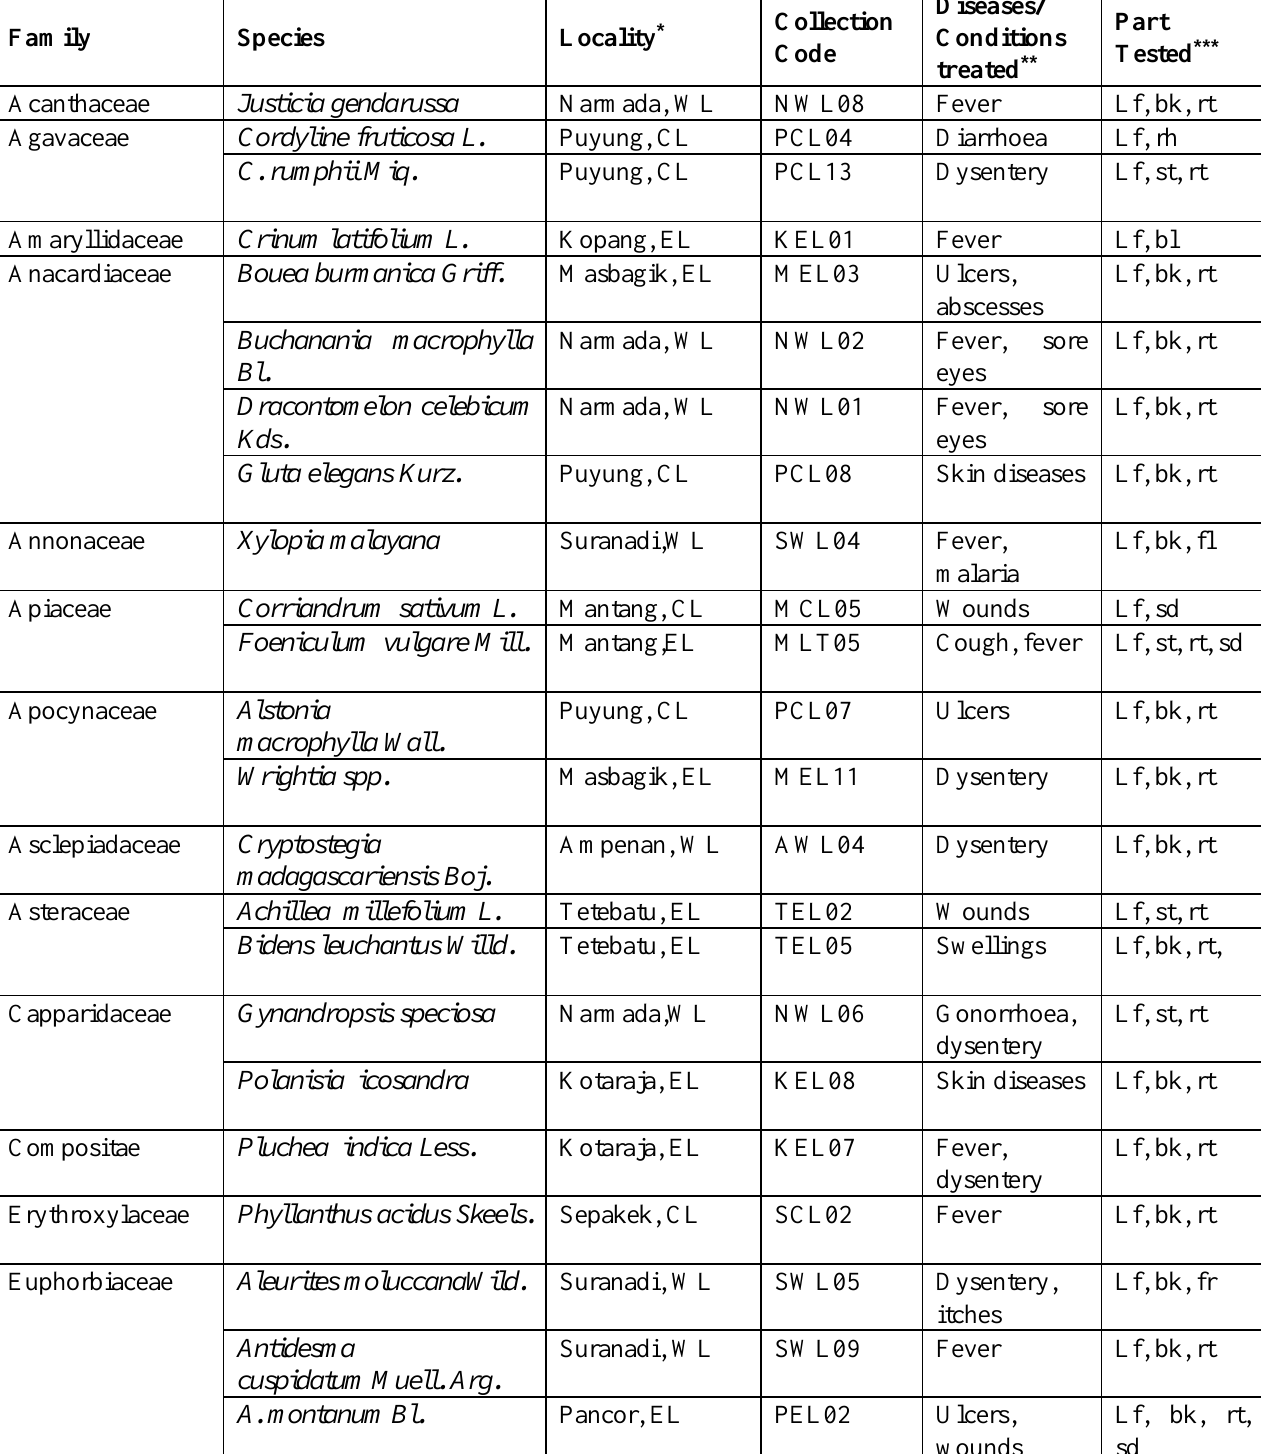
Table 1. Lombok medicinal plant species giving a negative test for